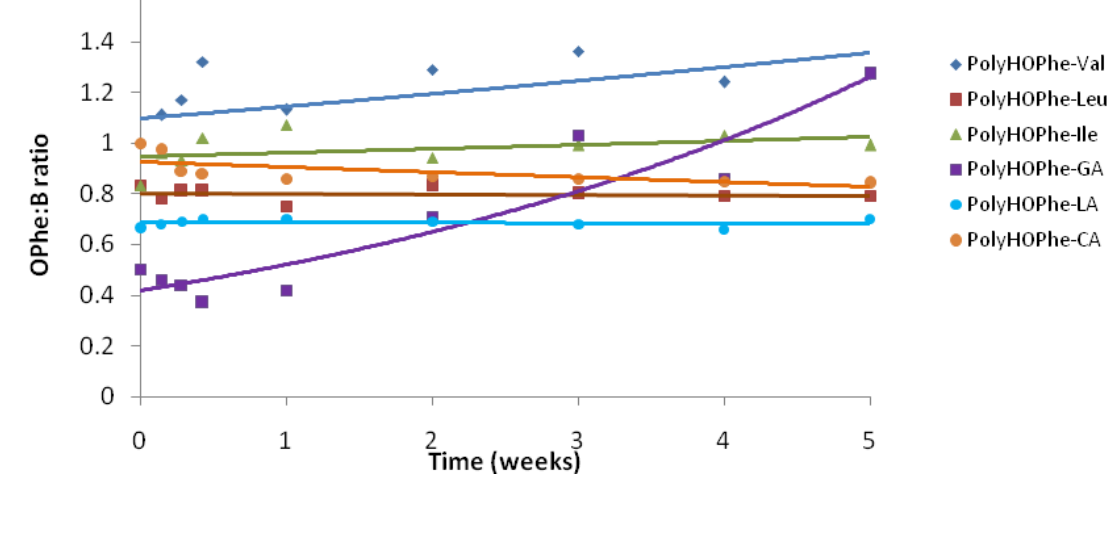
Figure 8. Composition of the HOPhe-B copolymers during degradation as been derived from NMR